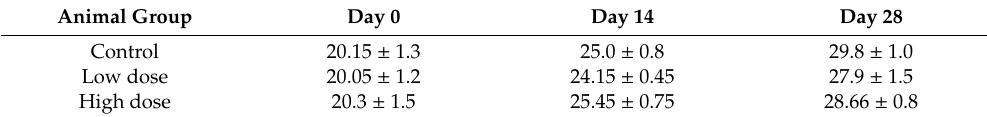
Table 3. Body mass of tested subjects throughout study duration (mean ± SD, n = 5).